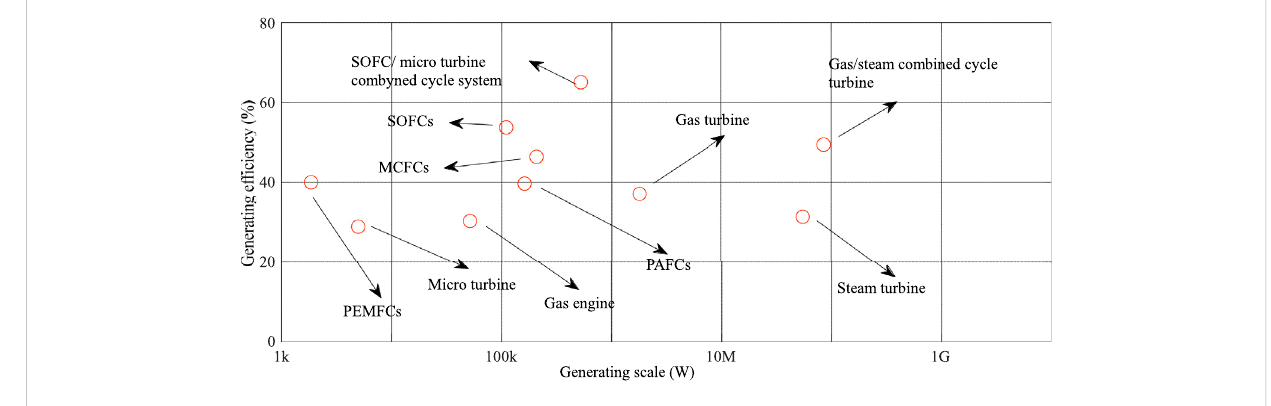
FIGURE 1 Ef fi ciency of the different fuel cells vs. generating scale.